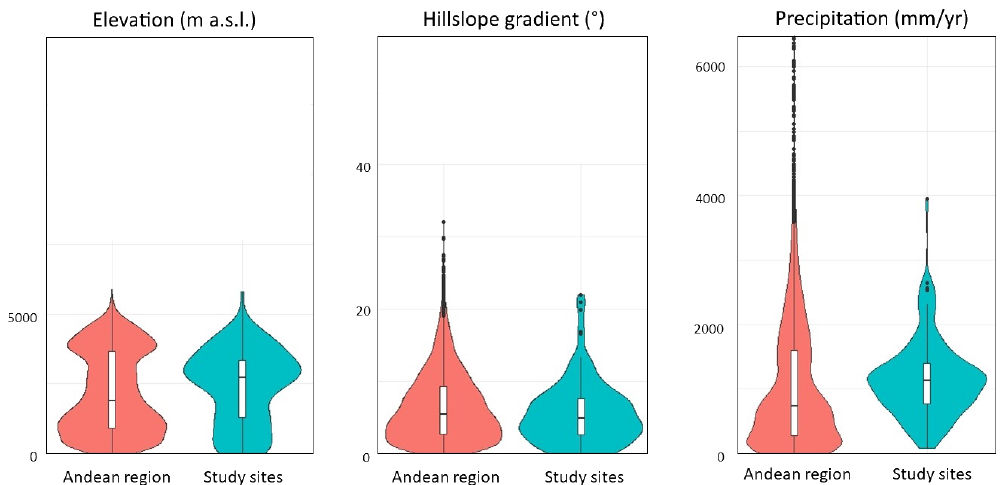
Figure 6. Distribution of the mean elevation (ma.s.l.), mean annual precipitation (mmyr − 1 ) and mean hillslope gradient ( ◦ ) for the 118 em- pirical studies and the entire Andean region. The delineation of the Andean region is based on Körner et al. (2017). The topographic informa- tion is derived from the 30arcsec DEM of South America (GTOPO30, U.S. Geological Survey’s Center for Earth Resources Observation and Science, EROS), and the mean annual precipitation data from the Tropical Rainfall Measuring Mission (TRMM 3B43) dataset (Ceccherini et al.,